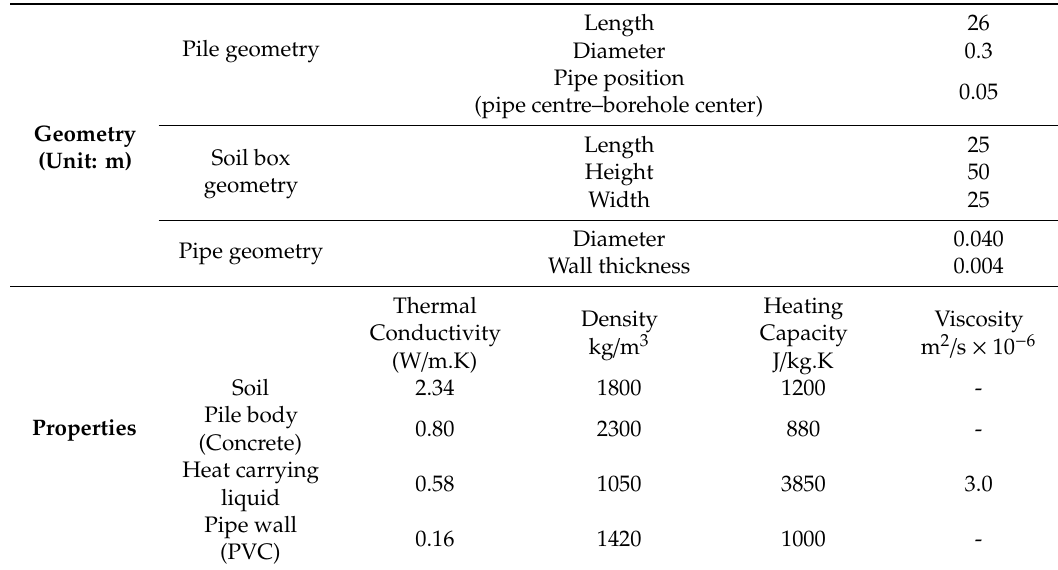
Figure 5. The hot-cold trial period of the Shell Centre energy pile. Table 2. Parameters for Shell Centre model.